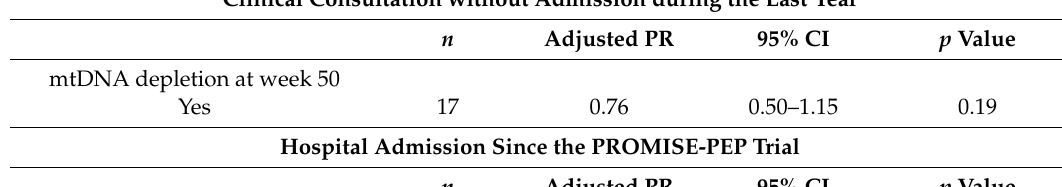
Table 4. Log-binomial regressions for the association between medical and biochemical outcomes at year 6 with CHEU having a mtDNA depletion at week